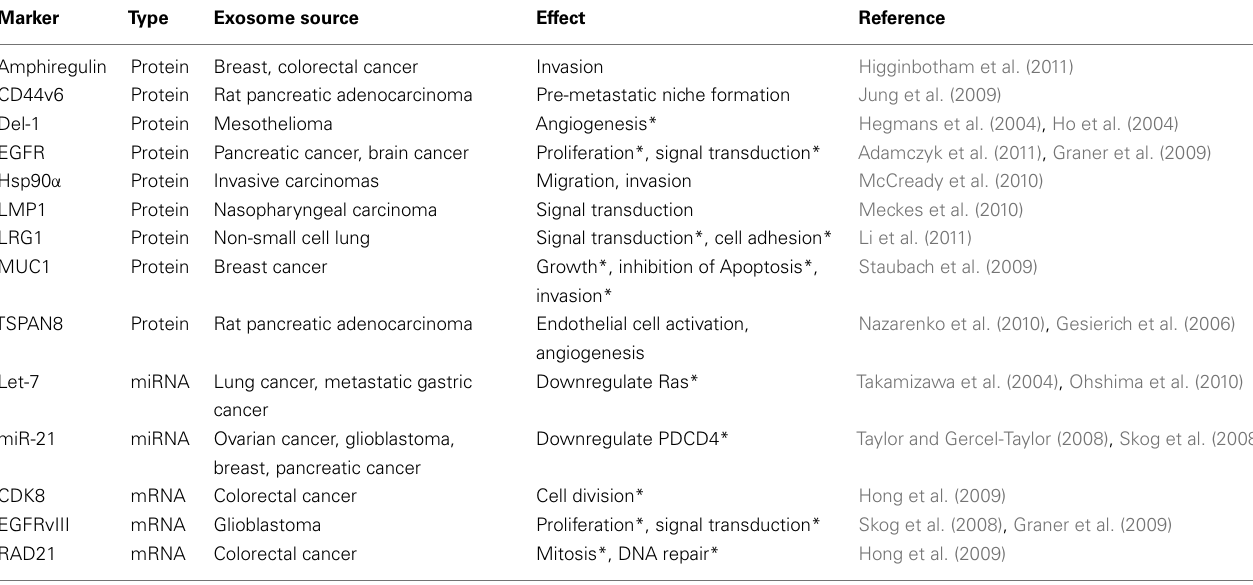
Table 1 | Summary of targets and markers isolated from cancer cell-derived